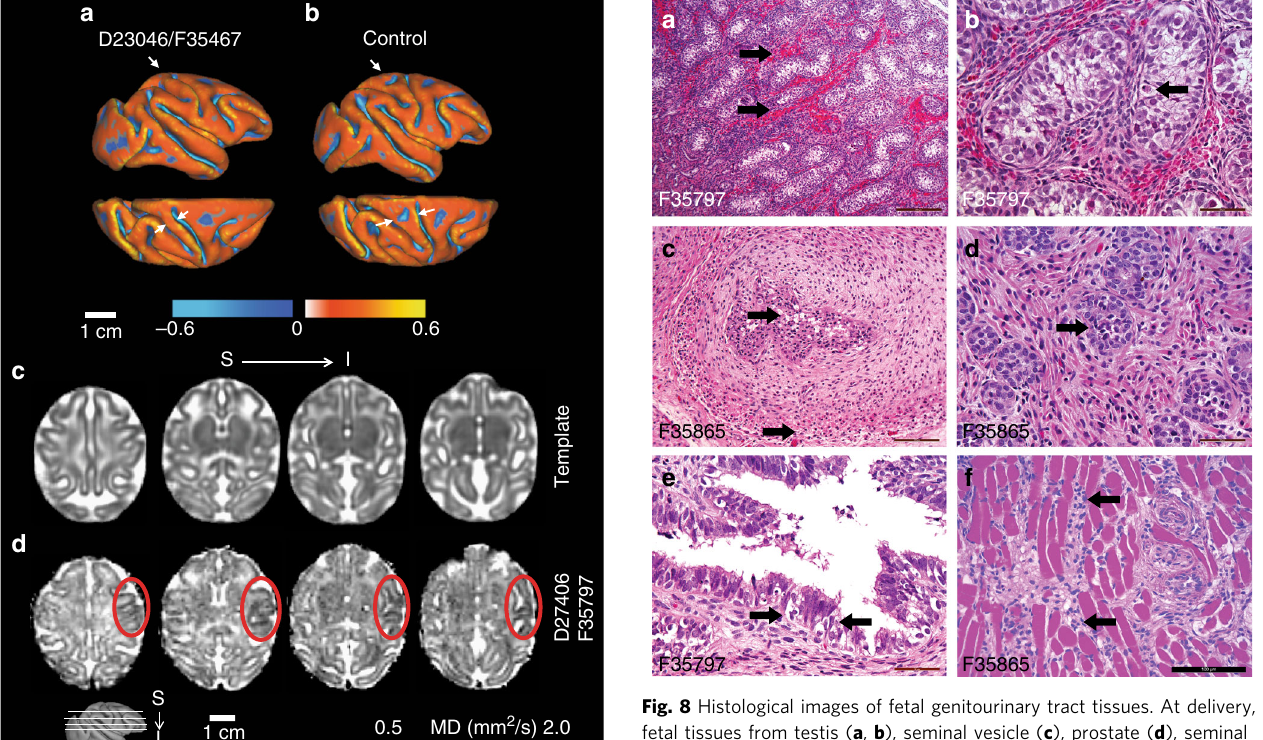
rendered on the surface (Fig. 7a, top, lateral view; bottom, dorsal view), and an age-matched control (Fig. 7b). The surface area of the post-central gyrus, quanti fi ed as the percent of isocortex, for 10 age-matched controls fetuses studied previously 52 . In these animals, the post-central gyrus occupies between 4.4 and 5.7% of the isocortex (mean ± SD of 5.04 ± 0.45). The post-central gyrus for animal F35467 occupied 4.3% of the isocortex, which is smaller than all 10 control animals previously studied, and 1.6 SD smaller than the average value for controls. In animal F35797, reduced apparent diffusion coef fi cient (ADC) was observed in the right motor, somatosensory, and auditory cortices compared to the left hemisphere (Fig. 7d, red circles). The cortical regions marked by lower ADC were continuous throughout multiple levels (Fig. 7d). An ADC map template generated from 8 control fetuses at matched gestational age show homogeneous cortical ADC between hemispheres, and throughout the entire cerebral cortex (Fig. 7c). At necropsy, brain tissue from the low ADC regions (Fig. 7d, red circles) was dissected and determined to be positive for ZIKV RNA. Interestingly, F35797 was the fetus of dam D27406, the only ZIKV-infected animal with microvascular